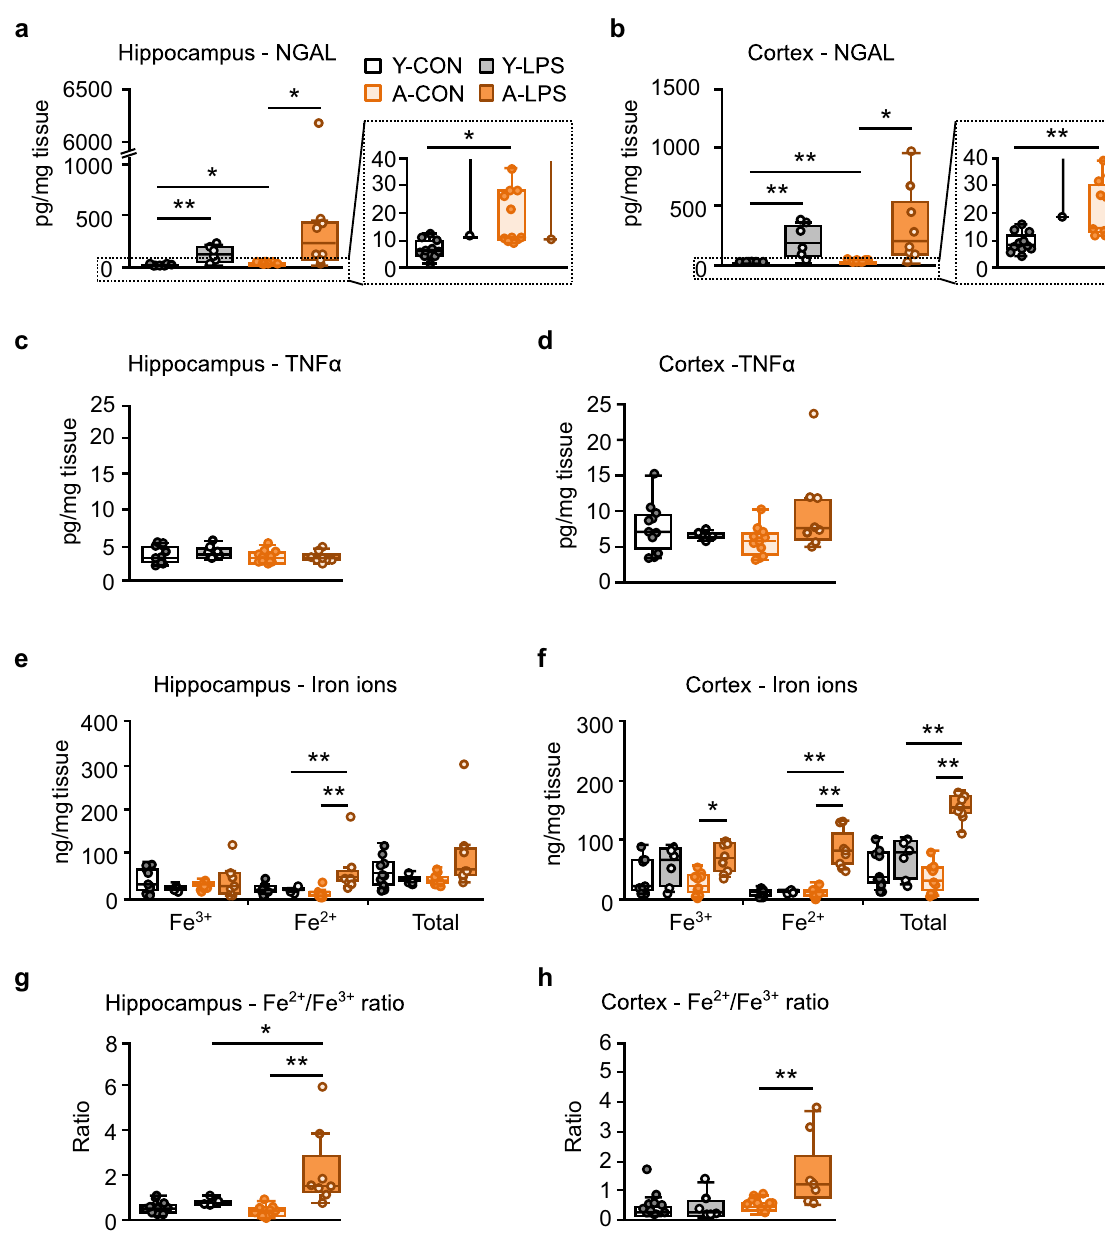
Figure 2. Aged sepsis-survivor rats showed neutrophil gelatinase-associated lipocalin (NGAL) elevations and dysregulation of iron homeostasis in the hippocampus and cortex. ( a , b ) The Y-LPS and A-LPS groups showed significant elevations of NGAL levels in the hippocampus and cortex. The hippocampal and cortical NGAL concentrations in the A-CON group were higher than those in the Y-CON group. ( c , d ) There were no significant changes in the hippocampal and cortical tumor necrosis factor α (TNFα) levels. ( e ) The A-LPS group displayed increases in the hippocampal Fe 2+ levels compared with the A-CON group. ( f ) The concentration of Fe 3+ , Fe 2+ , and total iron ion in the cortex in the A-LPS group was higher than those in the A-CON group. ( g , h ) The hippocampal and cortical Fe 2+ /Fe 3+ ratio of the A-LPS group was increased compared with those of the A-CON group. The data are presented as the median ± IQR. Y-CON, n = 11; Y-LPS, n = 6; A-CON, n = 11; A-LPS, n = 8. Permuted Brunner-Munzel test with Bonferroni correction, *P < 0.05, effect size p ̂ ≥ 0.87, **P < 0.01, p ̂ ≥